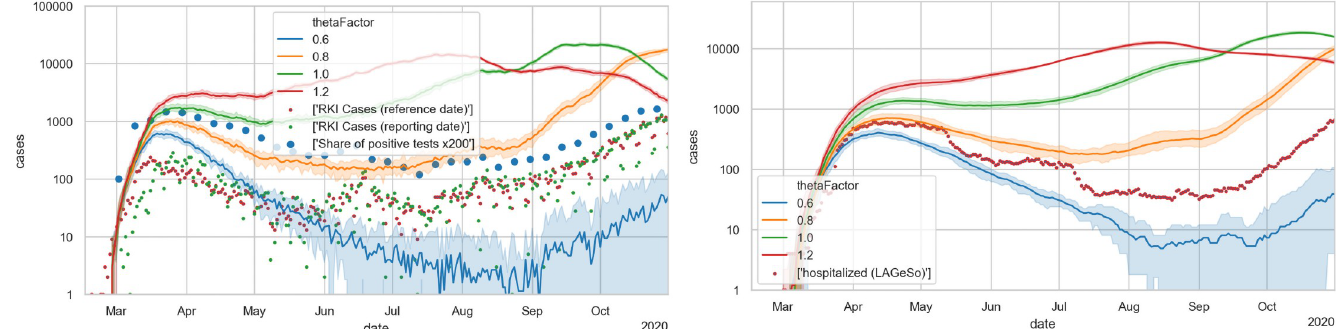
Fig 11. Simulations that now also include an asymmetric indoors/outdoors model, with a threshold temperature of 17.5C in spring, and 25C in fall. LEFT: new cases; RIGHT: hospital occupancies. A thetaFactor between 0.6 and 0.8 is most plausible, which would well reproduce the second wave (cf. in particular the hospital numbers).